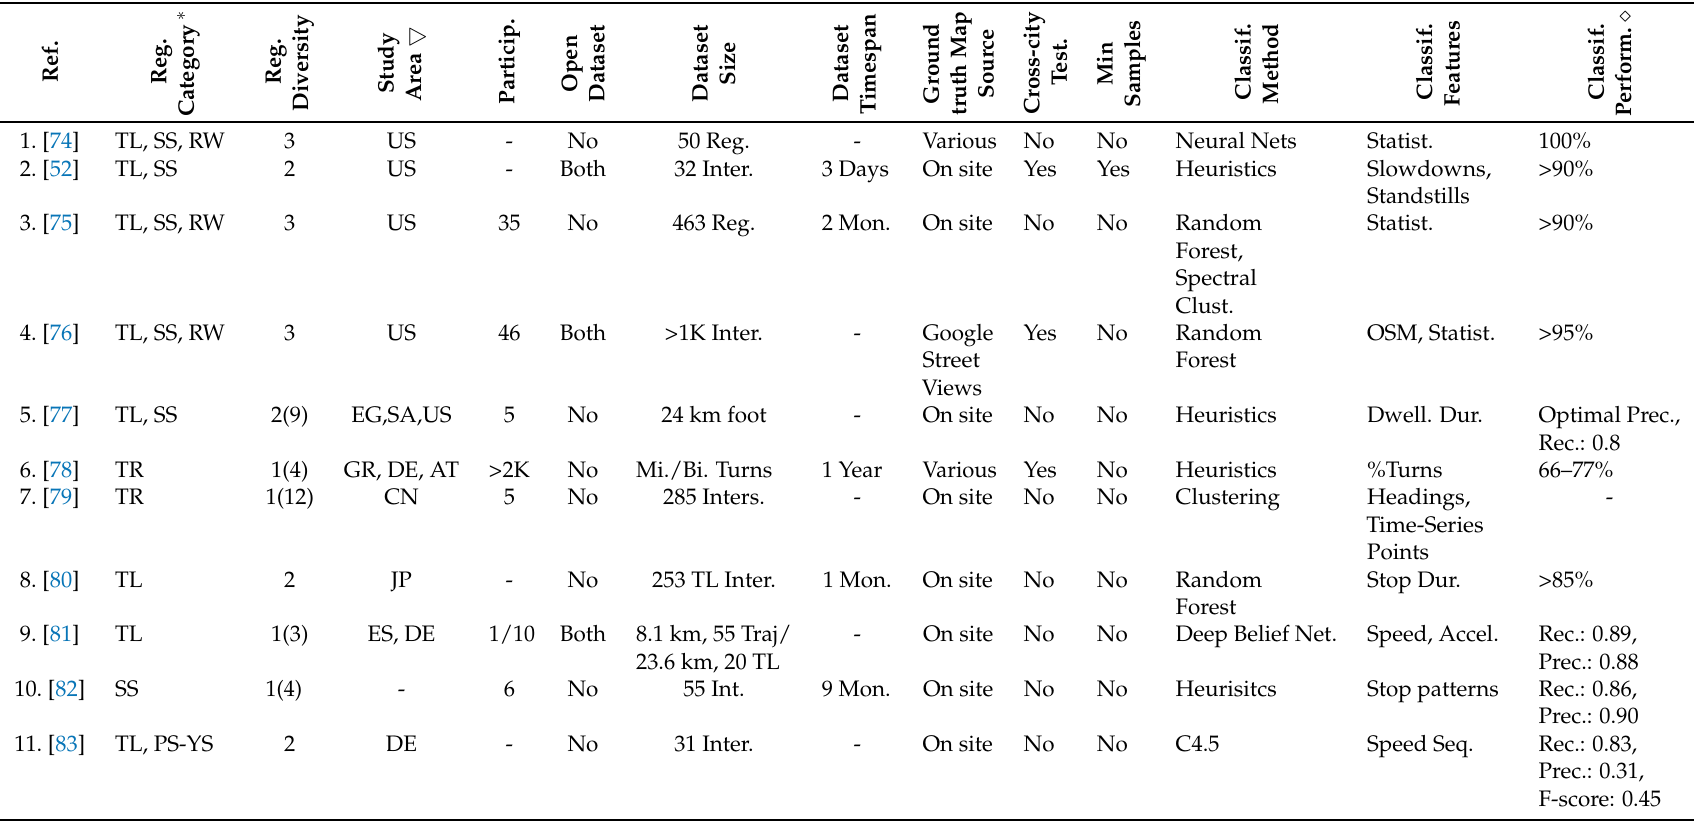
Table 10. Extracted information from the reviewed articles.